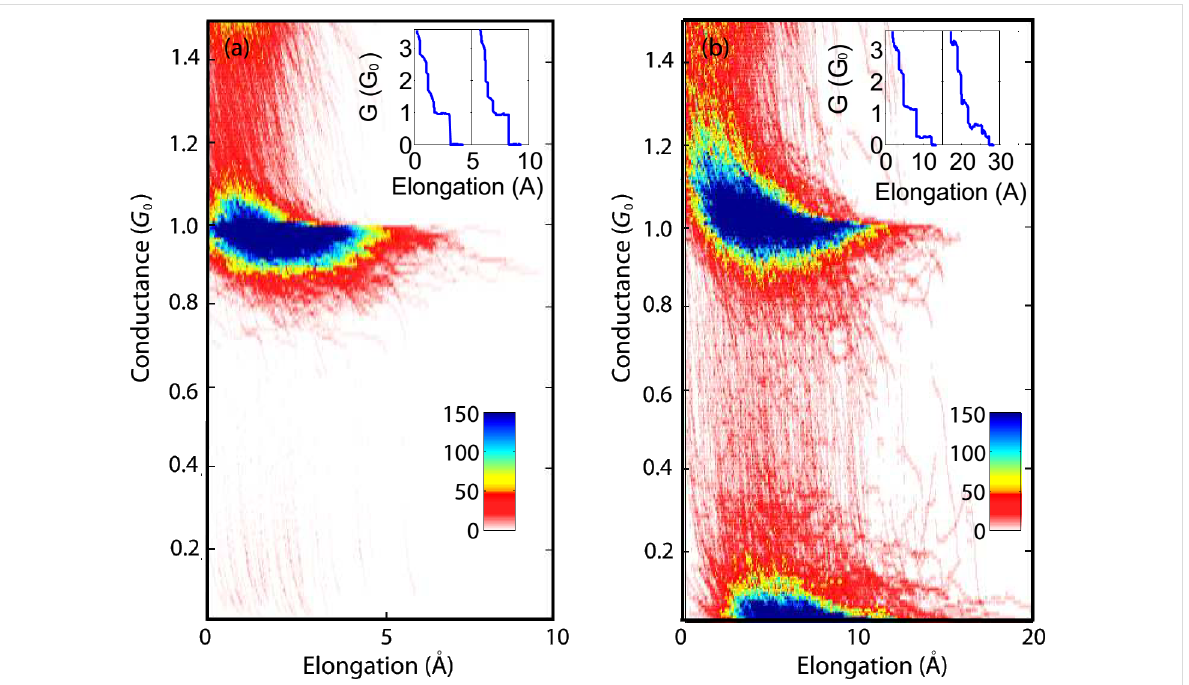
Figure 3: Conductance–length histograms, indicating the most probable conductance of the junction during the final stages of junction elongation before (a) and after (b) CuPc insertion. Both histograms were taken at a voltage of 50 mV, and the lower limit of the conductance scale was chosen as 0.02 G 0 to avoid contributions from instrumental noise. Insets: relevant representative conductance traces, measured while elongating the atomic (inset in (a)) and molecular (inset in (b)) junctions. The traces are shifted for clarity by 5 and 15 Å,